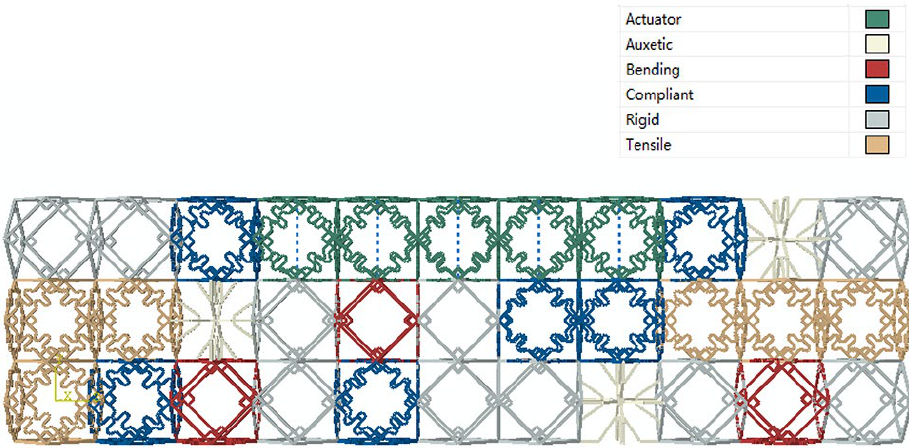
Figure 22. The optimal cell arrangement after convergence.